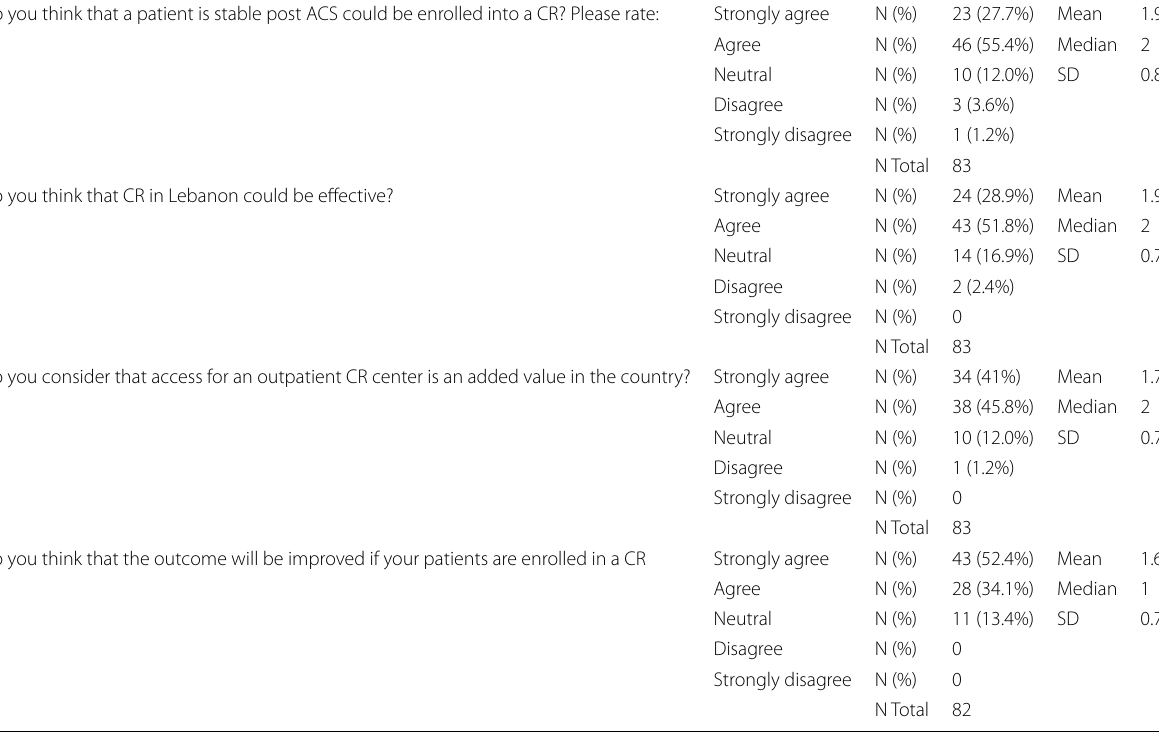
Table 3 Attitude toward cardiac rehabilitation (CR) among the